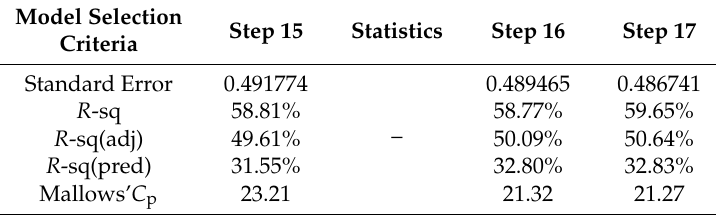
Table 7. Step wise selection procedure results